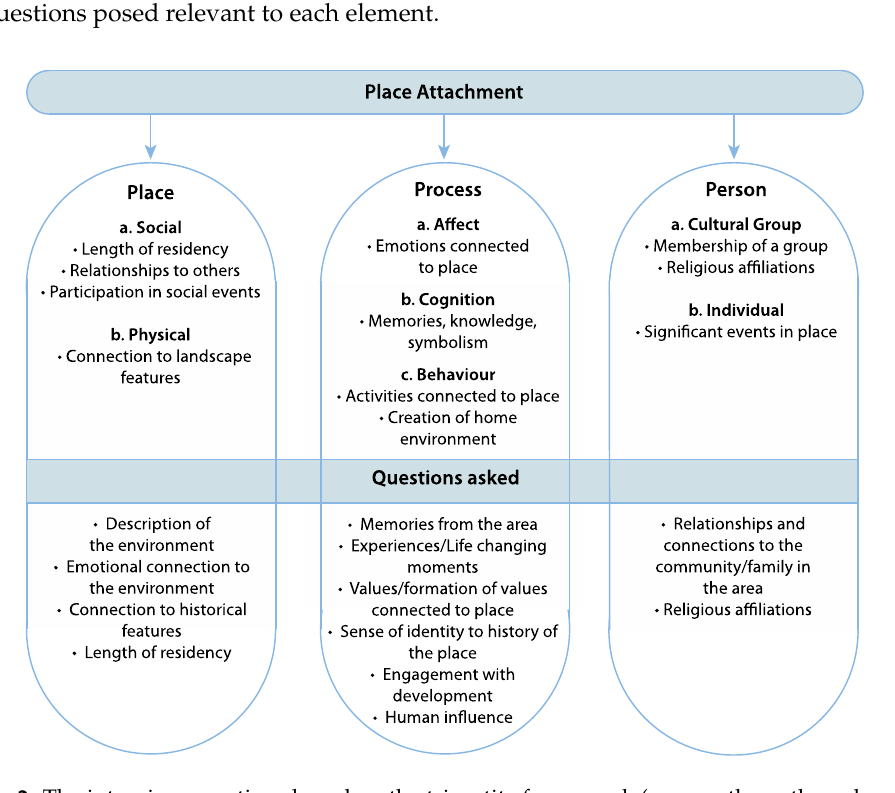
Figure 2. The interview questions based on the tripartite framework (source: the authors, based on Scannell and Gifford [48]).